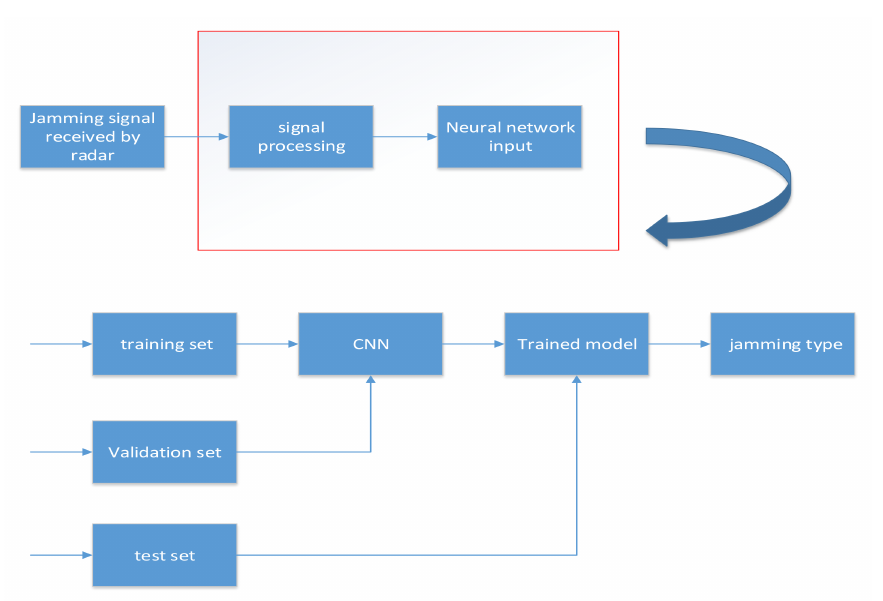
Figure 1. Basic structure of a CNN.